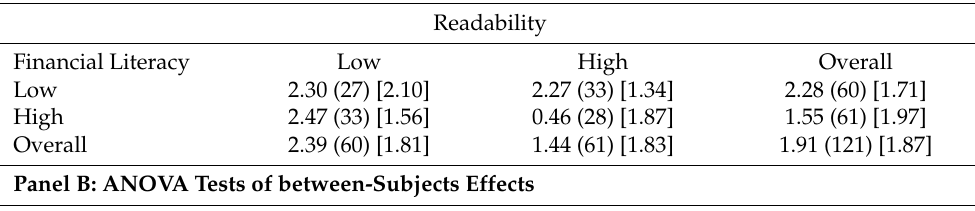
Table 1. Descriptive Statistics and Analysis of Variance (ANOVA): Future Performance Judgments. Panel A: Descriptive Statistics: Mean (Standard Deviation) [Sample Size] Readability